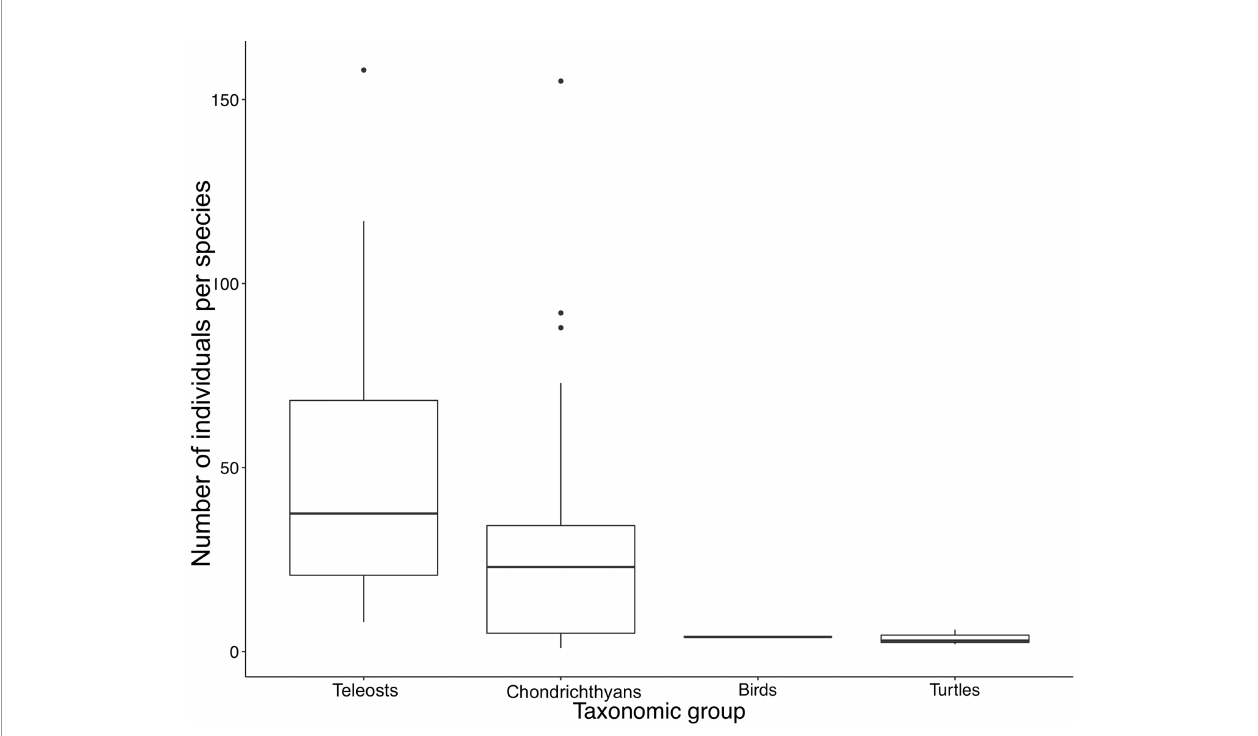
FIGURE 3 | Boxplot (median, fi rst and third quartiles, 1.5*IQR, outliers) of the number of individuals tagged per species within each taxonomic